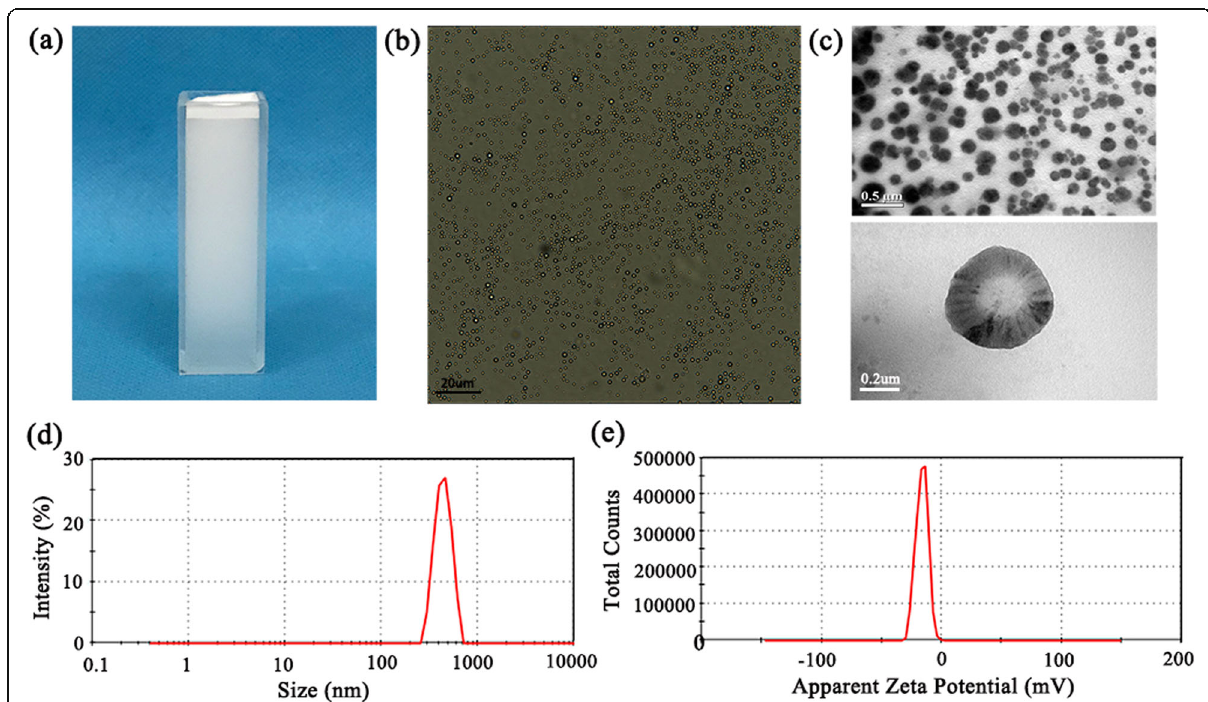
Fig. 1 a Photographs of N 2 O-mbs dispersed in deionized water; b image of N 2 O-mbs under bright-field optical microscopy; c transmission electron microscope image of N 2 O-mbs; d size distribution of N 2 O-mbs; e apparent zeta potential of N 2